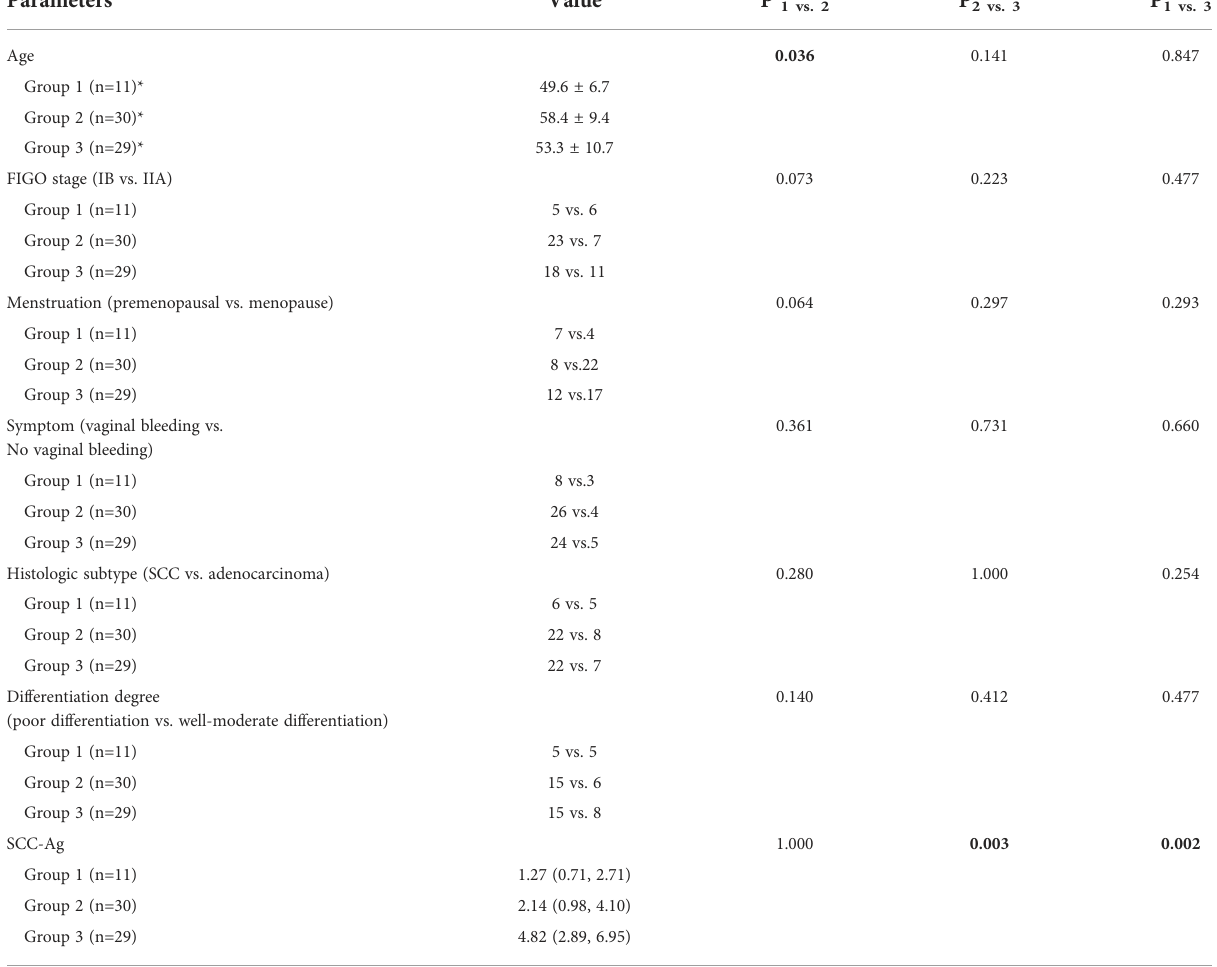
TABLE 5 Comparison of clinical characteristics, pathological features among the three